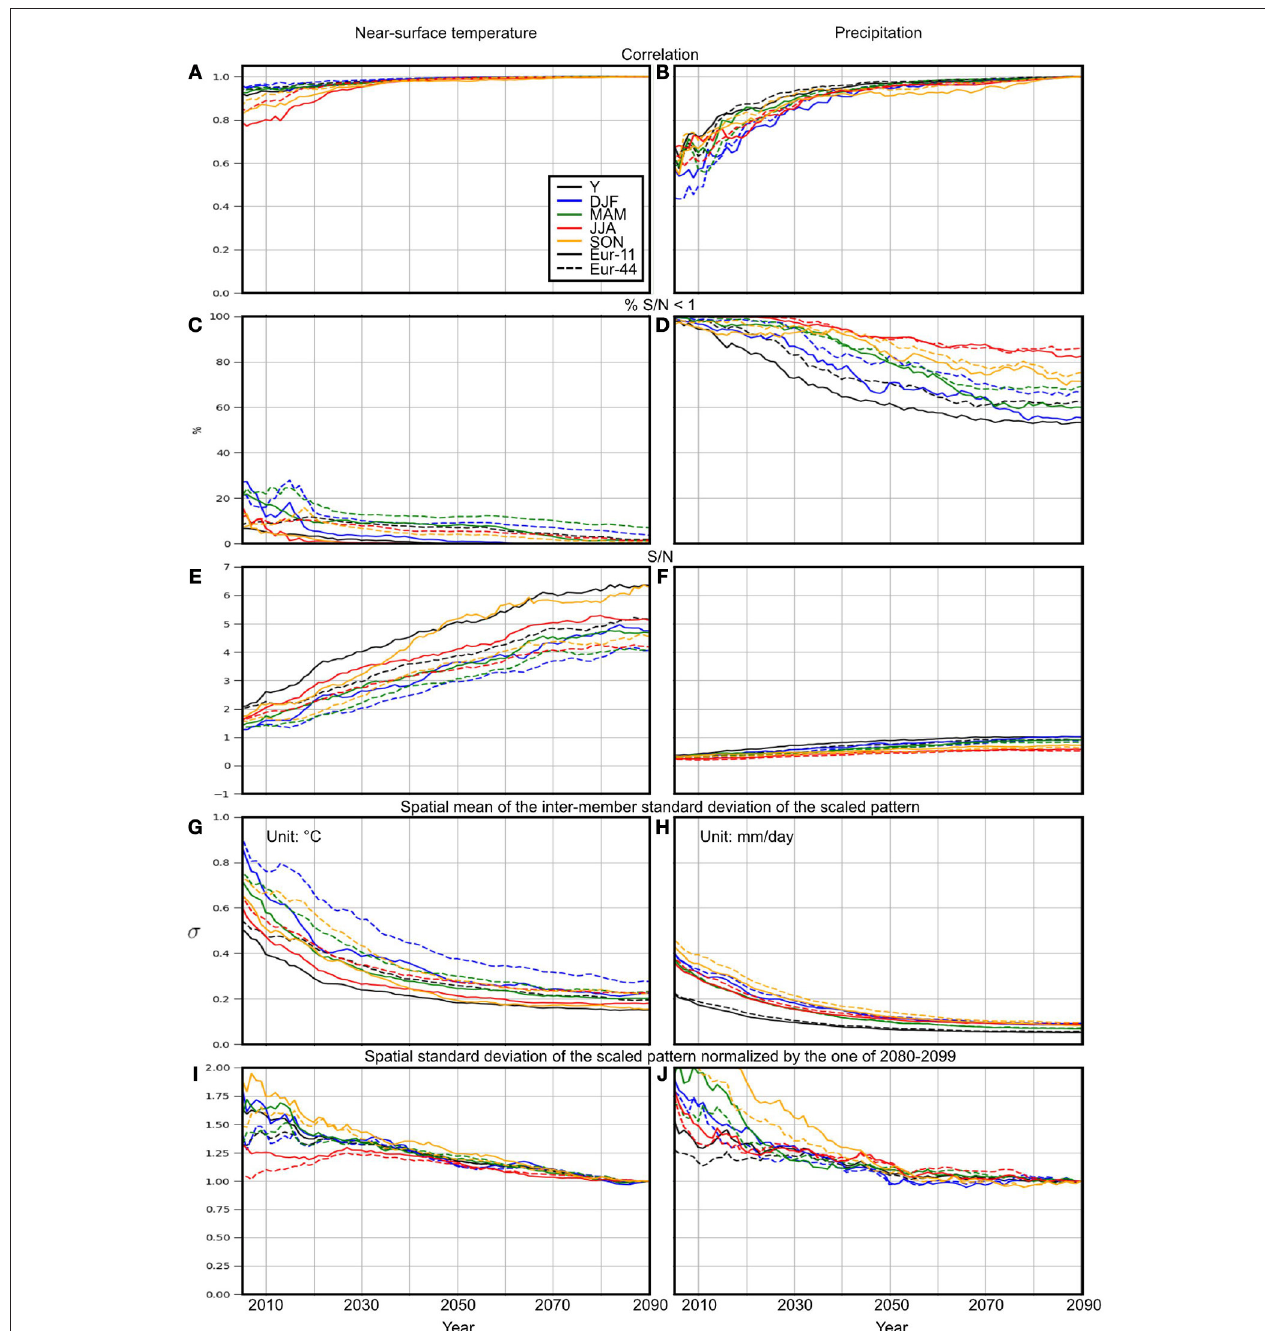
FIGURE 5 | Correlation between a running mean of 20-years scaled patterns from 2005 to 2090 (central year shown) against corresponding end-period levels (2080–2099) (A,B) . Percentage of grid points where S/N < 1 (C,D) . Spatial average of the S/N levels (using the absolute signal) of the scaled patterns (E,F) . Spatial average of inter-member standard deviation of the scaled patterns (G,H) . Spatial standard deviation of scaled patterns normalized by that of 2080–2099 (I,J) . The results are shown for both variables (temperature and absolute precipitation, left and right respectively), and across resolutions and seasons as well as